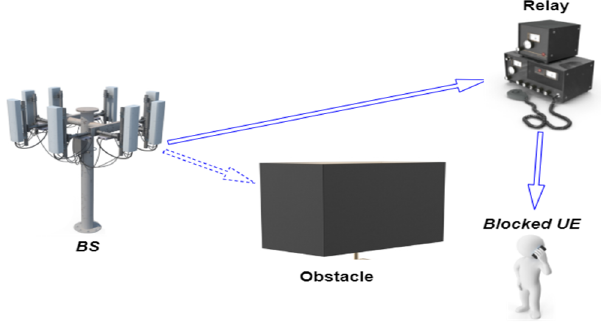
Figure 2. Relay-based transmission strategy.